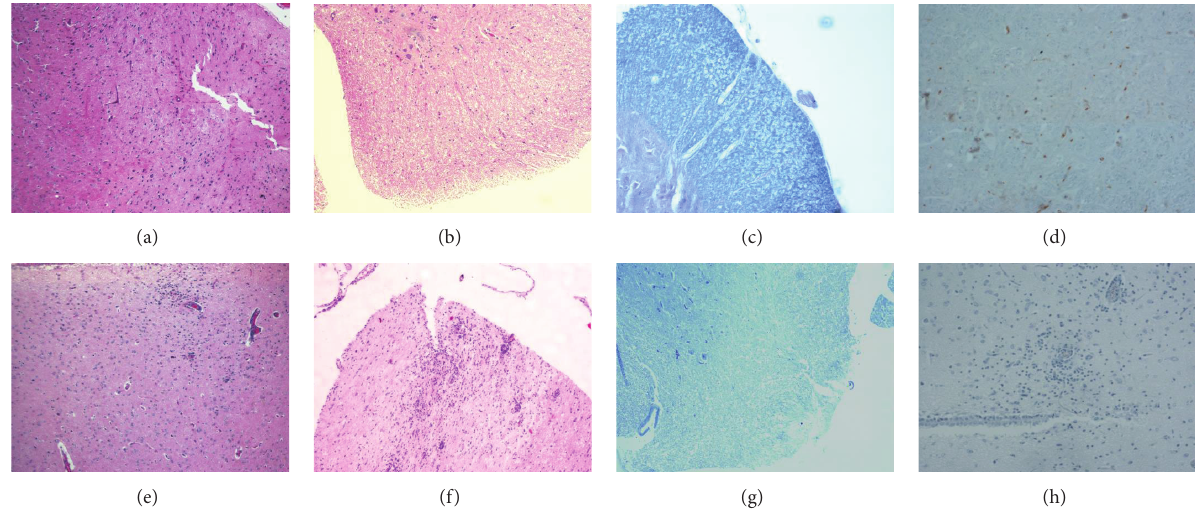
Figure 2: Treatment with the cPLA 2 inhibitor AX059 reduced brain and spinal cord damage in EAE induced in Lewis rats. The figures shows hematoxylin and eosin (H&E)-stained sections from AX059-treated ((a) brain; (b) spinal cord) and vehicle-treated ((e) brain; (f) spinal cord) rats; spinal cord sections from AX059-treated (c) or vehicle-treated (g) rats stained with Luxol fast blue; and Foxp3 expression in spinal cord sections from AX059-treated (d) or vehicle-treated (h) rats by immunohistochemical staining.